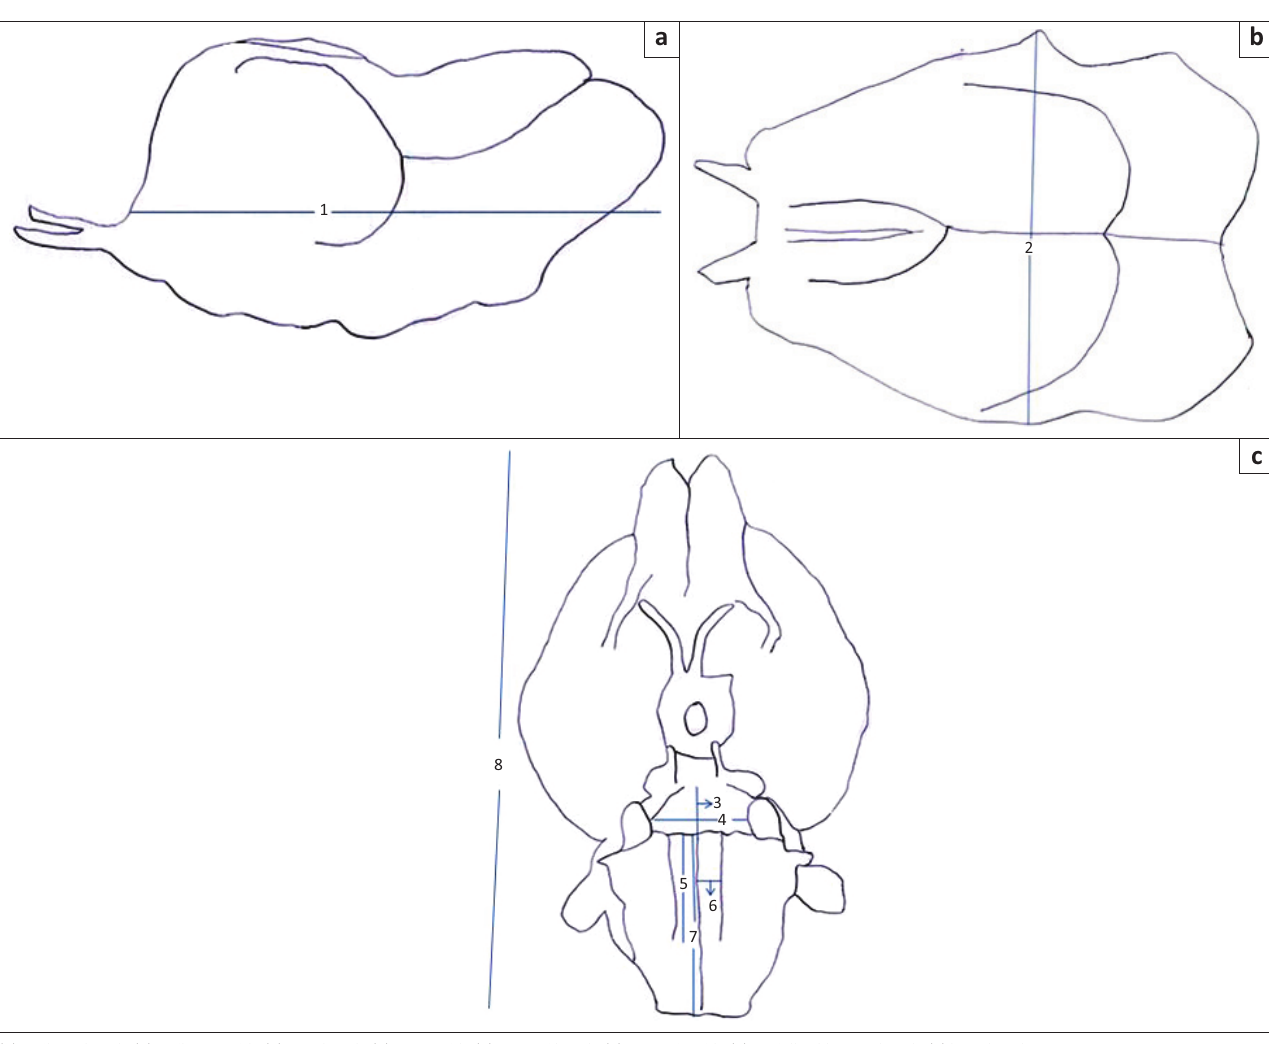
FIGURE 1: Landmark for morphometric values. (a) Lateral view of midbrain, (b) dorsal view of midbrain and (c) ventral view of the brain. TABLE 1: Age-specific allometry of the midbrain in the African grasscutter (mean ± SEM). Midbrain parameter